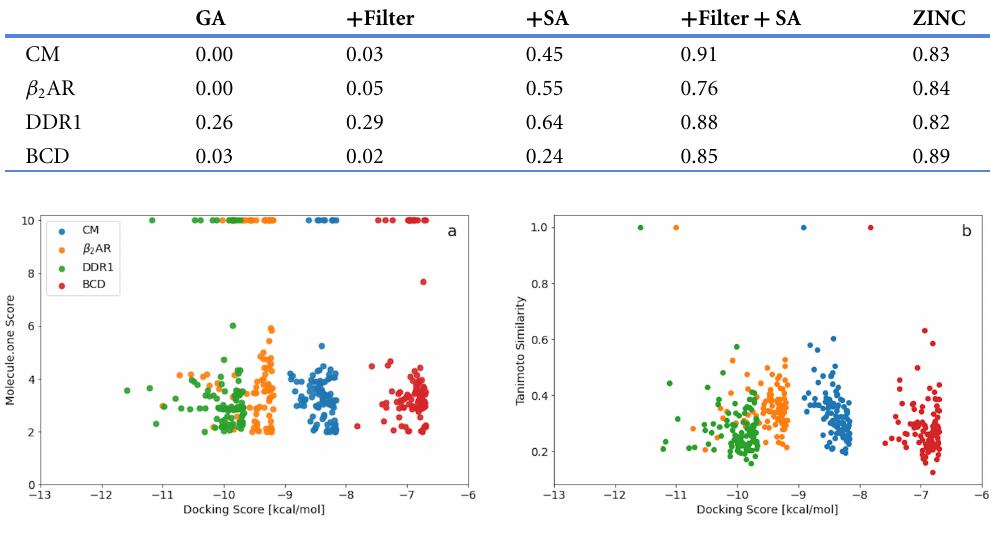
Table 4 Fraction of the 100 top scoring molecules that are deemed synthetically accessible by Molecule.one.